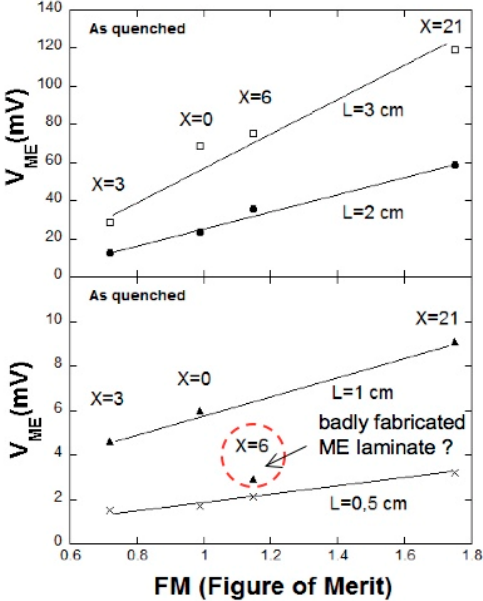
Figure 10. Maximum ME voltages of laminates fabricated with different magnetostrictive constituents and also different lengths, as a function of the figure of merit of each metallic glass. Figure modified from reference [11], with permission of the author.